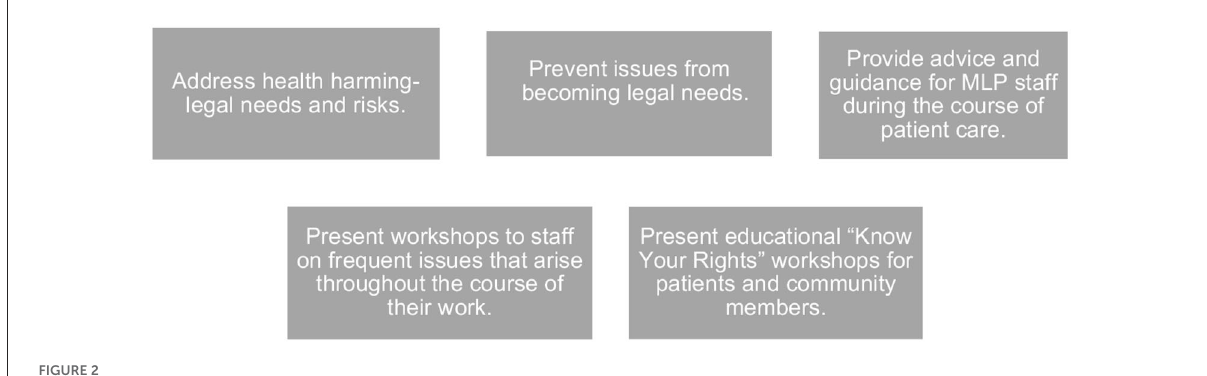
FIGURE2 Added value of attorney in health care